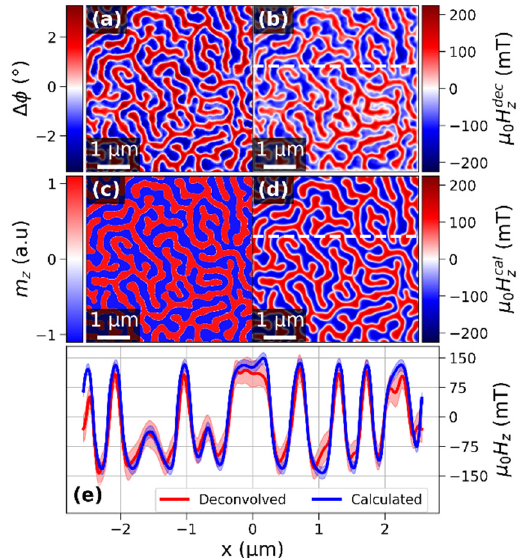
Figure 5. ( a ) MFM phase shift data of the [Pt/Co] 100 sample and ( b ) quantitative perpendicular stray field components, B z , data, calculated thereof using Ti/Pt/Co calibrated qMFM; ( c ) sample magnetization pattern from discrimination of the phase shift data followed by a convolution with a domain wall kernel and ( d ) perpendicular stray field components, B z , data, calculated thereof by forward simulation using the known micromagnetic material parameters; ( e ) plotlines of the perpendicular stray field components, B z , taken along the dashed lines of the stray field images together with uncertainty